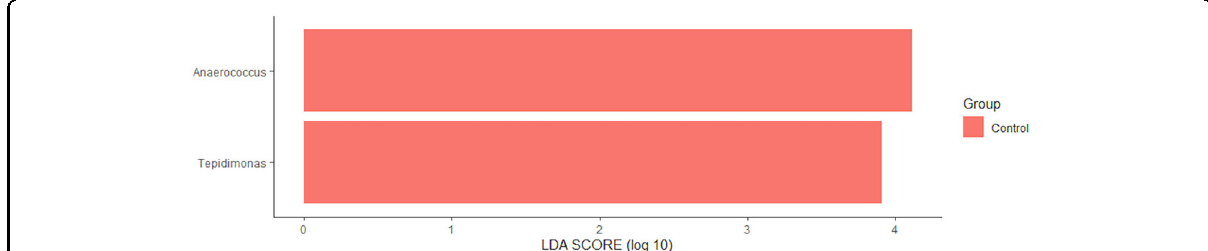
Fig. 2 Linear discriminant analysis (LDA) showing distinct bacterial genera in the sinus. Signi fi cantly differentially abundant genera with P < 0.05 and LDA score >3 were observed.